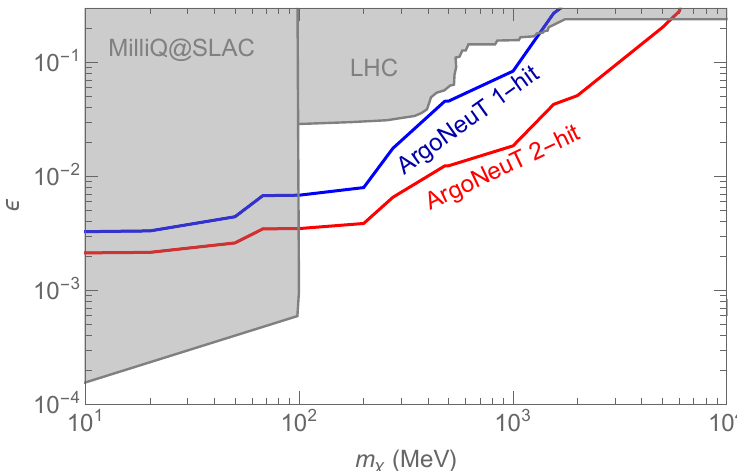
Figure 4 . The physics reach in the m χ - (cid:30) plane for millicharged particles achievable by the Ar- goNeuT experiment with existing data with 10 20 POT. The reach of a single-hit analysis is shown in blue and that of a double-hit analysis, requiring that the two hits line up with the target, is shown in red. Existing limits from other experiments, including SLAC MilliQ [16] and collider experiments [26–29], are shown in